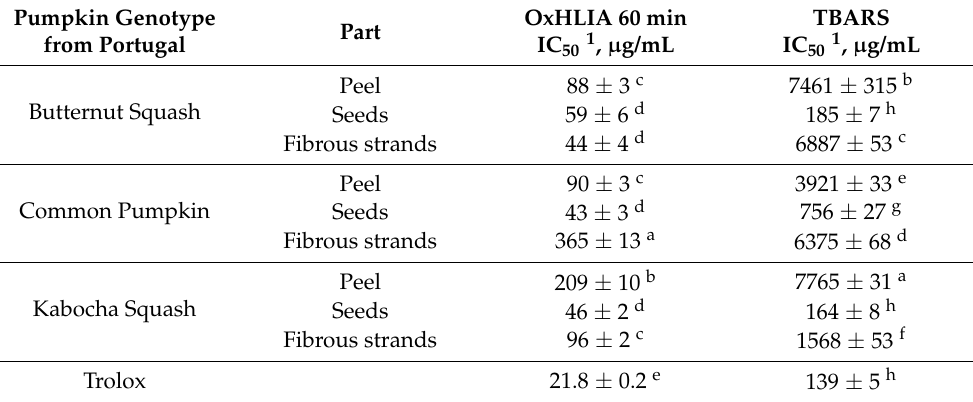
Table 4. Antioxidant activity of the byproducts of three pumpkin genotypes from Portugal, obtained through cell-based assays.